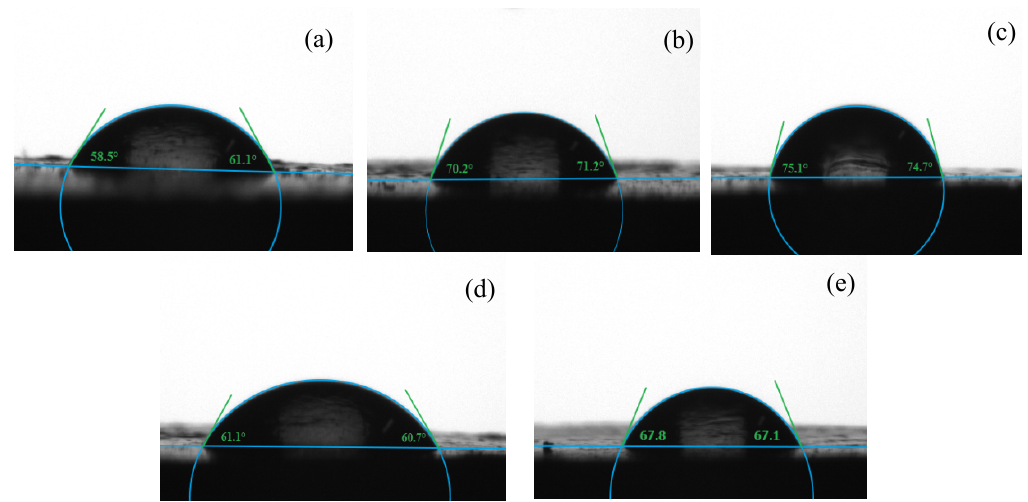
Figure 12. Contact angle of flotation products for different flotation types: ( a ) Conventional flotation without collector; ( b ) Conventional flotation with collector; ( c ) HCCS; ( d ) HCSS; and ( e ) HCWS.